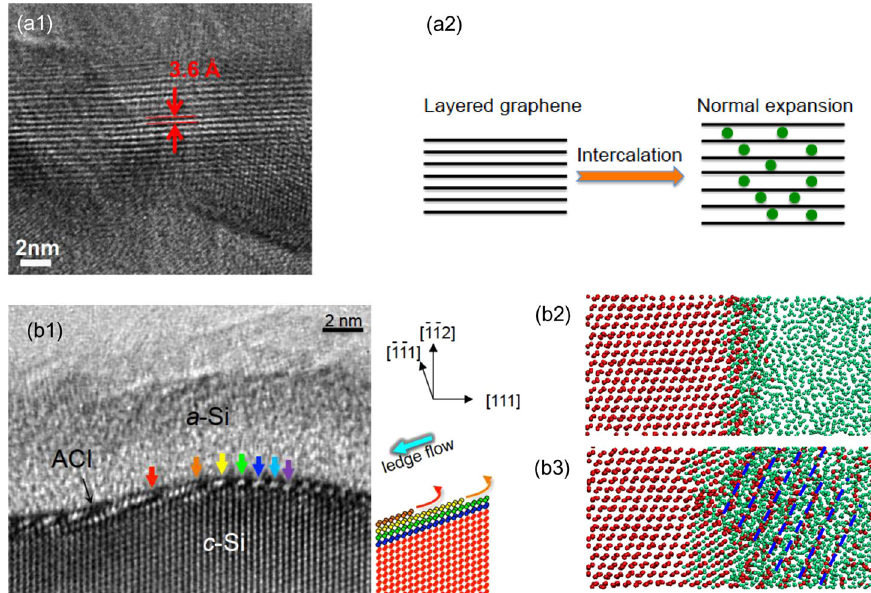
Fig. 2 Two typical lithiation mechanisms: intercalation (e.g., layered graphene) vs. alloying (e.g., Si). a 1 A TEM image shows Li intercalation to layered graphene, causing interlayer expansion from 3.4 Å to 3.6 Å. 53 a2 Schematics showing Li intercalation into layered graphene. b1 A TEM image showing alloying of c -Si during lithiation, involving bond breaking, directional ledge fl ow, layered-by-layer peel-off, and solid-state amorphization. 81 b2 , b3 Two sequential snapshots from atomistic simulations showing the amorphization process in c -Si during